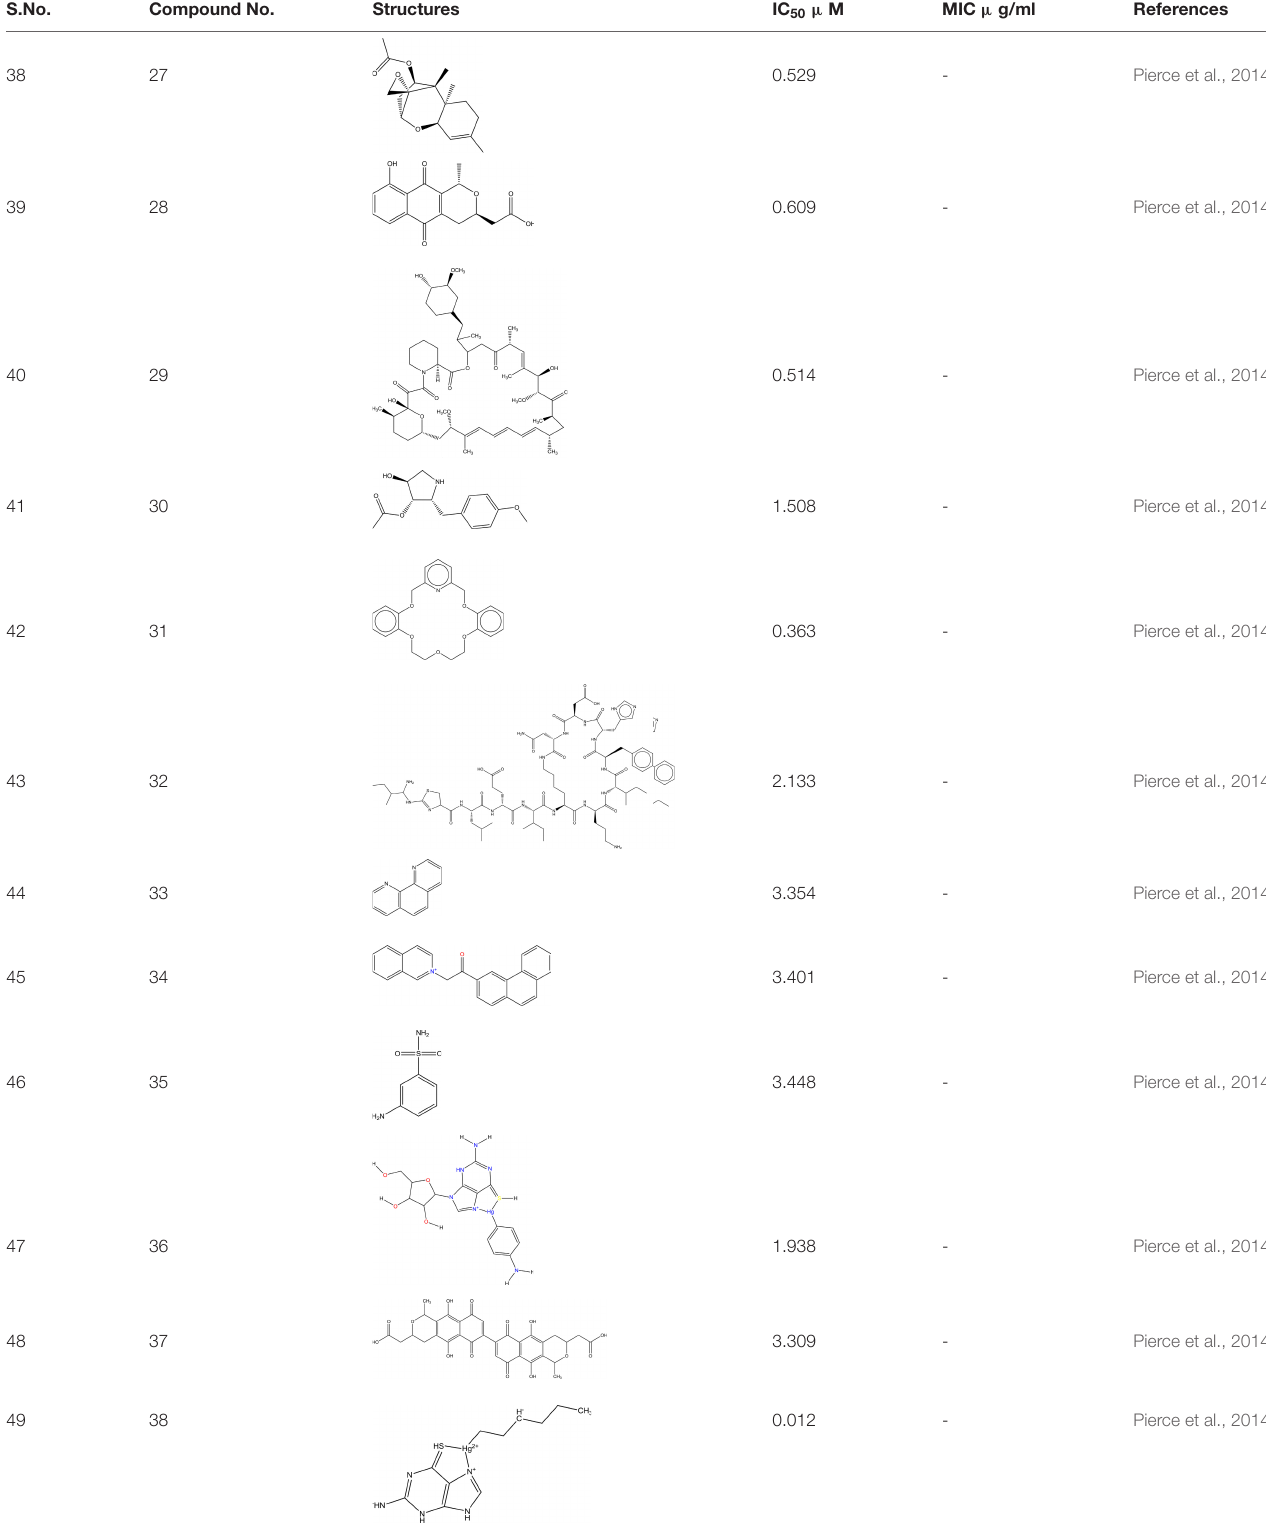
TABLE 3 | Chemical structures and MIC/IC 50 values of small molecule inhibitors (27–48). S.No. Compound